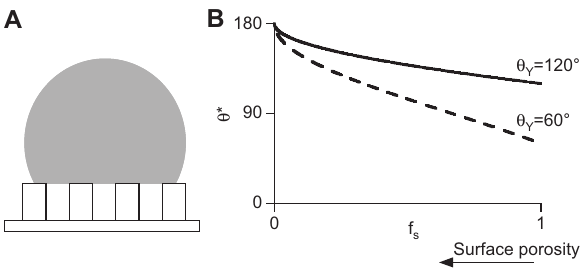
Figure 3 (A) The Cassie-Baxter scenario where a water drop sits on a “ composite ” surface of air and solid – heterogeneous wetting regime. (B) Apparent contact angle, θ *, as a function of the solid fraction f for an inherent hydrophilic (with θ s